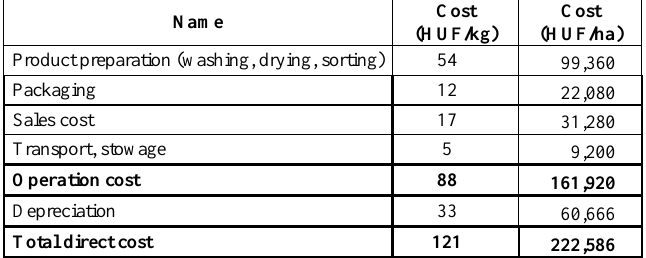
Table 3. Postharvest cost of walnut as per dried